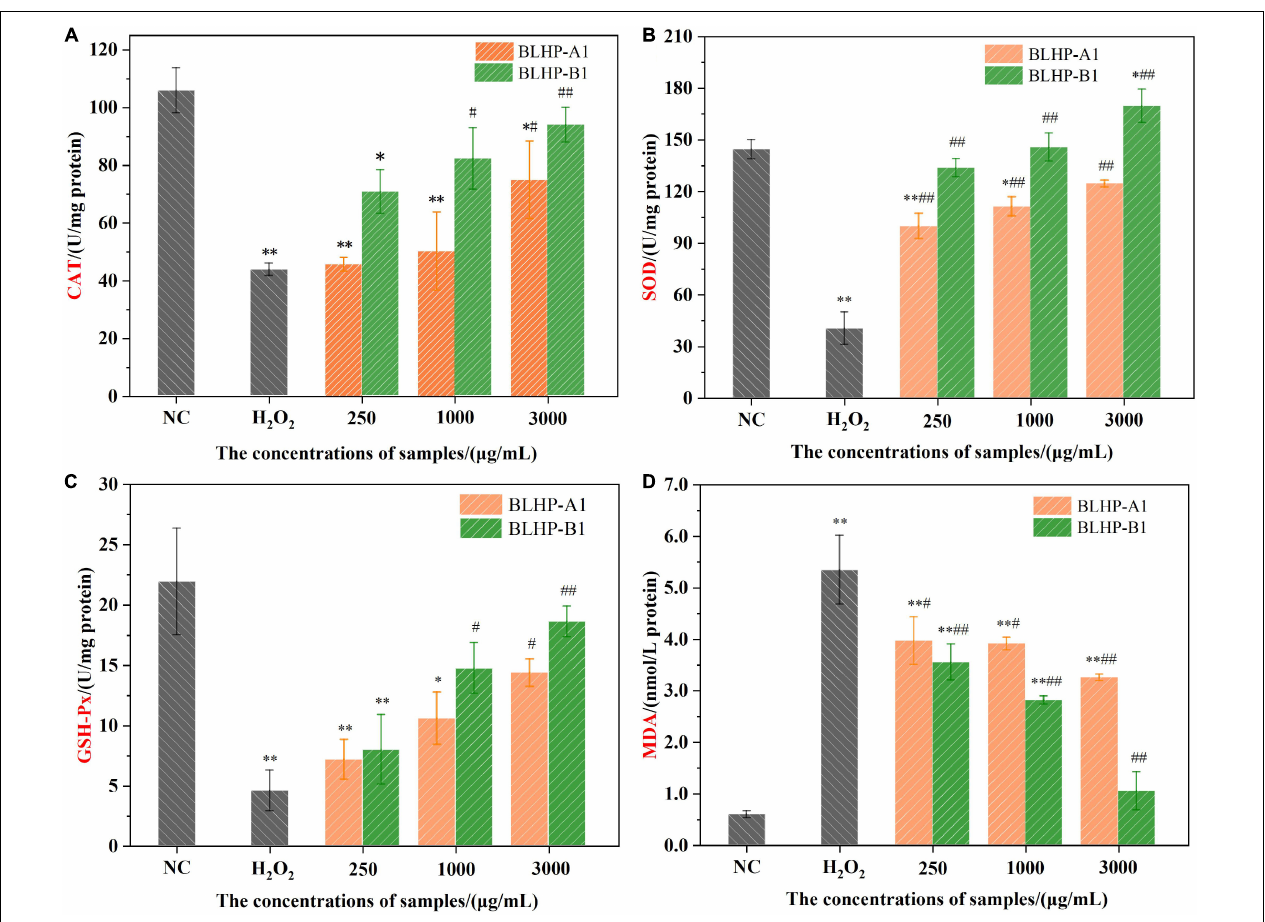
FIGURE 9 | The effects of BLHP samples on the concentrations of antioxidant enzymes CAT (A) , SOD (B) , GSH-Px (C) and MDA (D) product. NC, normal control; H 2 O 2 : H 2 O 2 (600 µ moL/ml) induced group. ( ∗ p < 0.05, ∗∗ p < 0.01 compared with the control group; # p < 0.05, ## p < 0.01 compared with the H 2 O 2